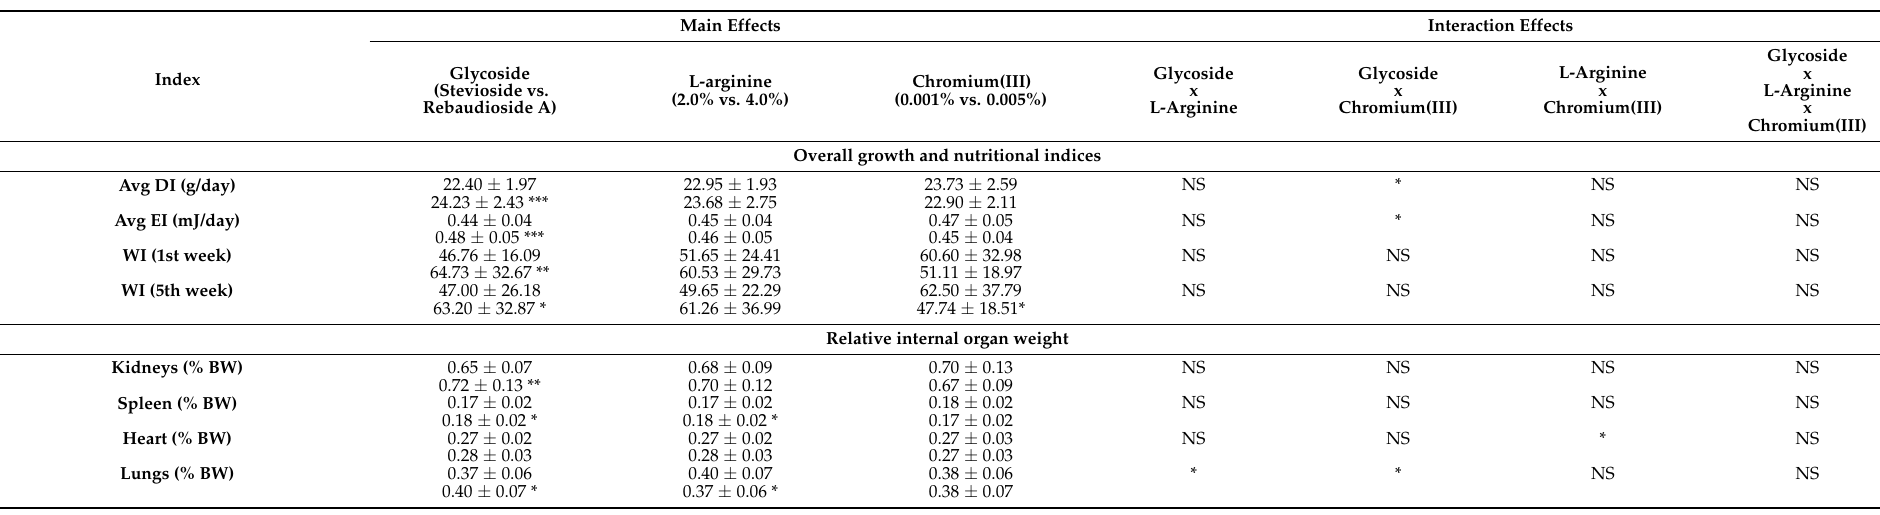
Table 2. Main and interaction effects of SG, L-arg, and Cr(III) supplementation (independently and in combination) in rats (three-way analysis of